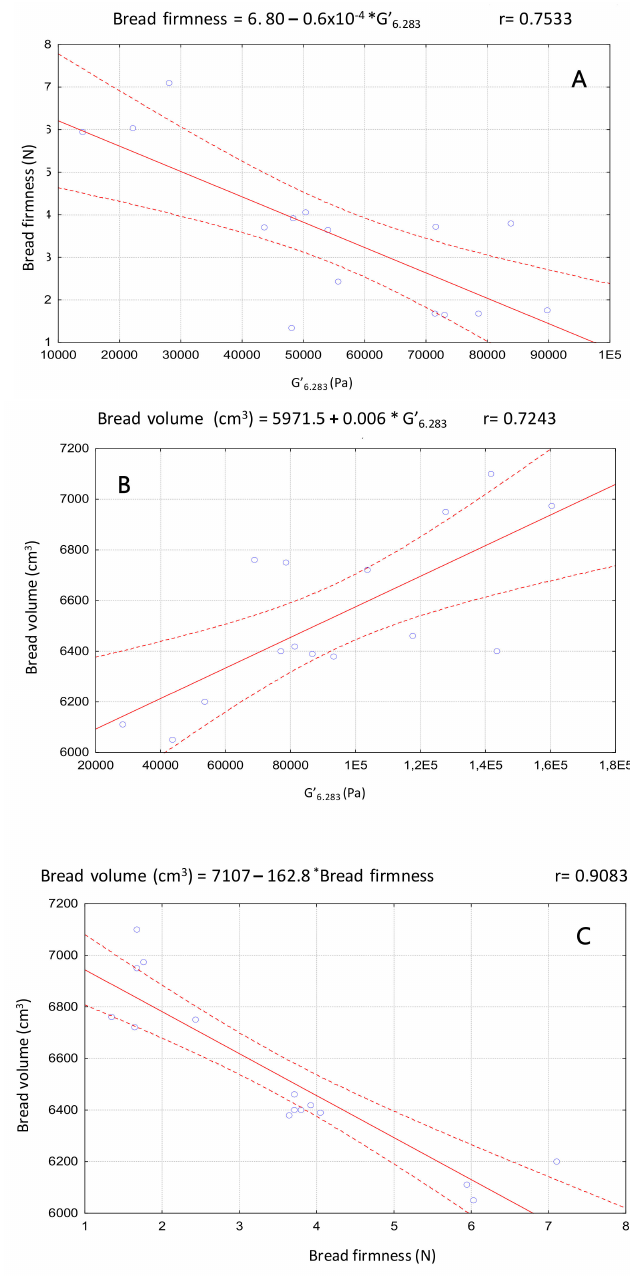
Figure 5. Mathematical correlations between GF breadmaking properties and dough rheology ( p < 0.05). ( A ) Bread firmness and G’ 6.283 rad / s ; ( B ) Bread volume and G’ 6.263 rad / s ; ( C ) Bread volume and bread